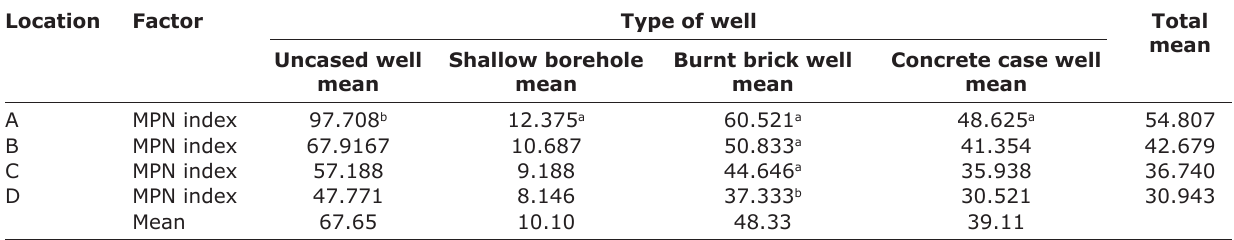
Values are mean±SEM, n=192, Rows with different superscripts are significantly different at p≤0.05, a Significantly increased with reference to the dry season value, b Significantly decreased with reference to dry season value, A=Modern Market community, B=North bank community, C=Kanshio community, D=Fiidi community